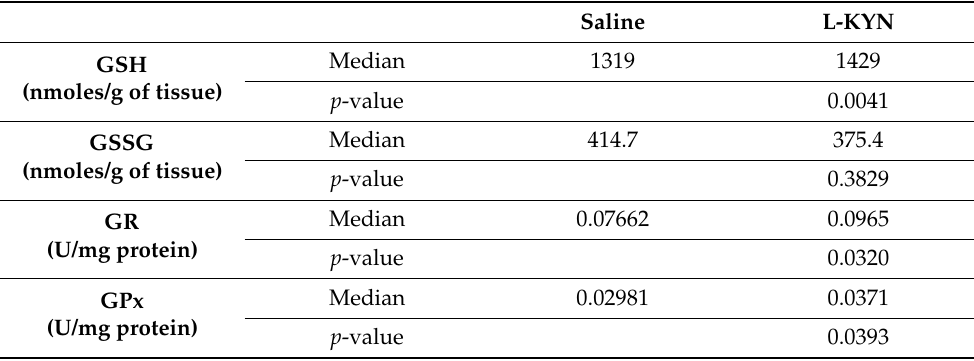
Table 5. Effect of sub-chronic L-KYN administration on the brain antioxidant environment. Medians of GSH and GSSG levels, GR and GPx enzymatic activities and p -values associated with the effect of L-KYN compared to Saline, using the Mann–Whitney test.